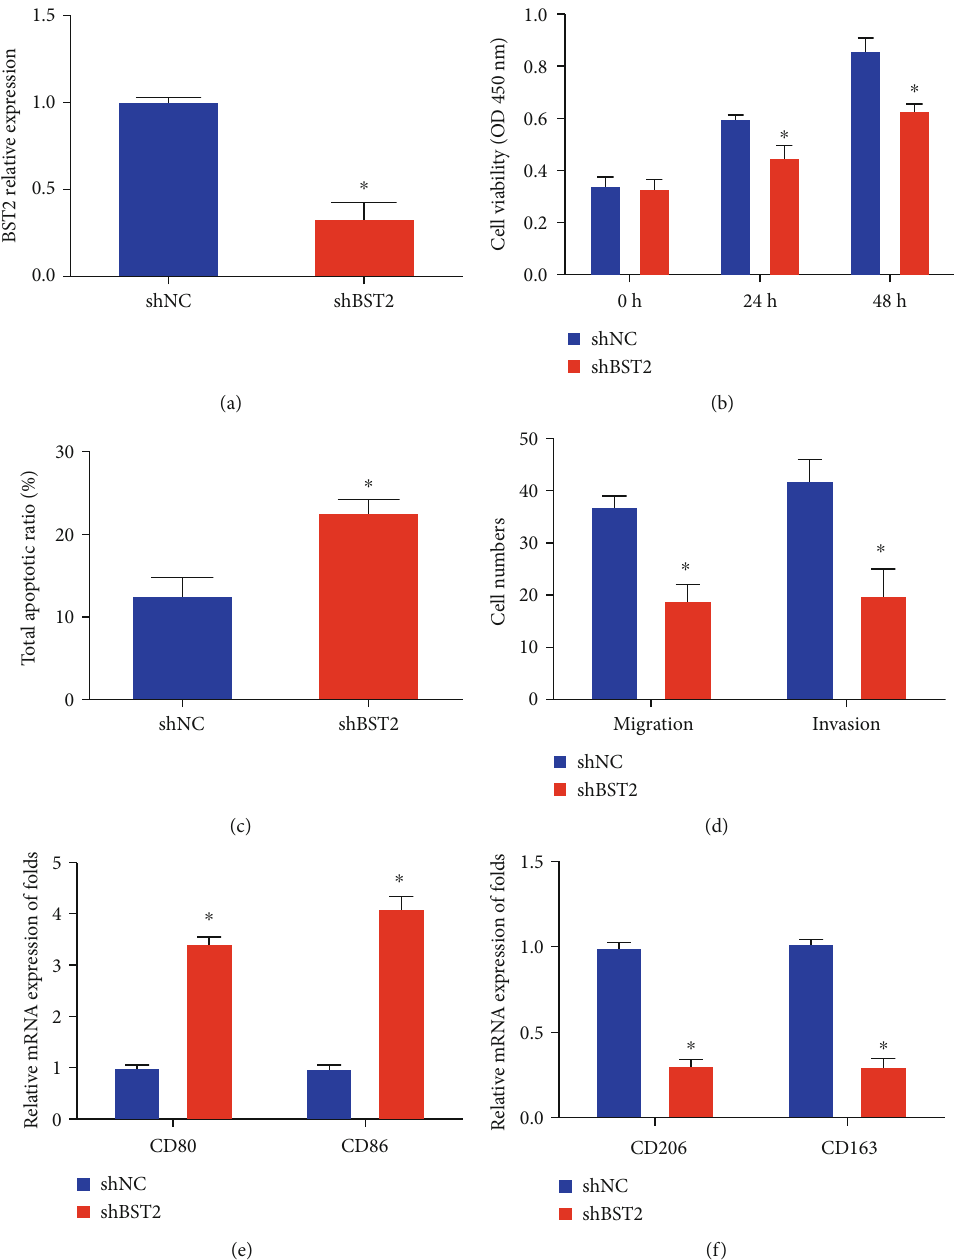
Figure 5: BST2 promoted cervical cancer progression via inducing M2 macrophage polarization. (a) mRNA levels of BST2 in SiHa cells transfected with BST2 shRNA. (b) Cell viability by CCK8 assay. (c) Cell apoptosis by TUNEL assay. (d) Migration and invasion capacity by Transwell assay. (e) mRNA expression of CD80 and CD86 in macrophages. (f) mRNA expression of CD206 and CD163 in M0 macrophages transfected with BST2 shRNA. ∗ P < 0 : 05 . Three independent assays were carried